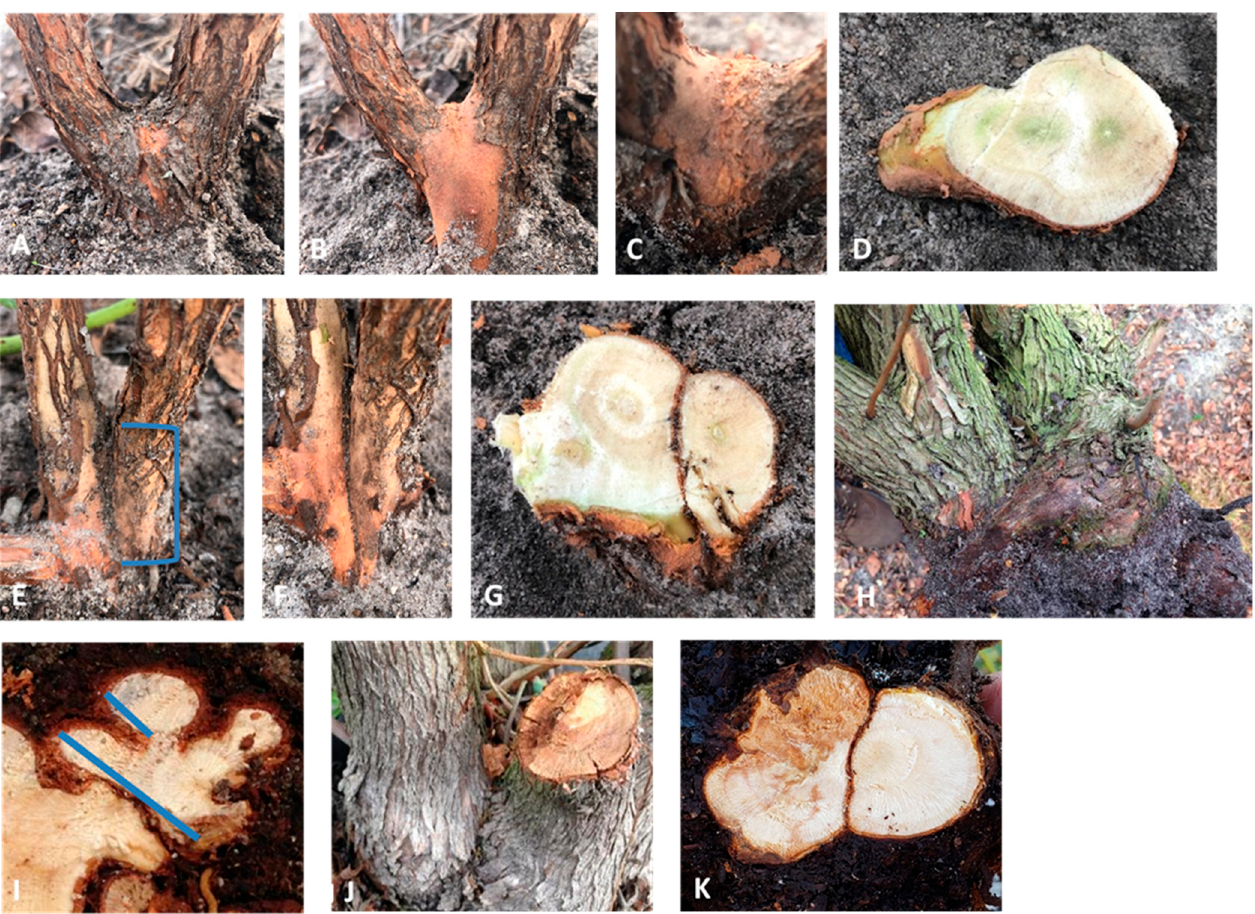
Figure 1. Anatomy of normally formed southern highbush cane unions ( A – D ) compared with those having included bark ( E – K ). External view of a normally formed cane union prior to ( A ) and after removal of loose bark ( B , C ). Note raised line of callus between the two canes in ( C ), with no bark inclusion visible internally in the cross-section of the cane union ( D ). This is compared with a narrow, V-shaped cane union with included bark that can be viewed externally by an inward ridgeline bark layer ( E , F ) and internally as compressed bark in the cane union cross-section ( G ). Another symptom of bark inclusions can be identified externally as girdling roots at the basal crown ( H ) and internally as bark fissures across the cane cross-section or as a partial invagination on one side of the cane ( I ). Diseased, necrotic cane tissue due to stem blight ( J ) can be differentiated from dark, compressed bark inclusion line ( K ). Blue brackets or lines indicate length of included bark or bark fissure.